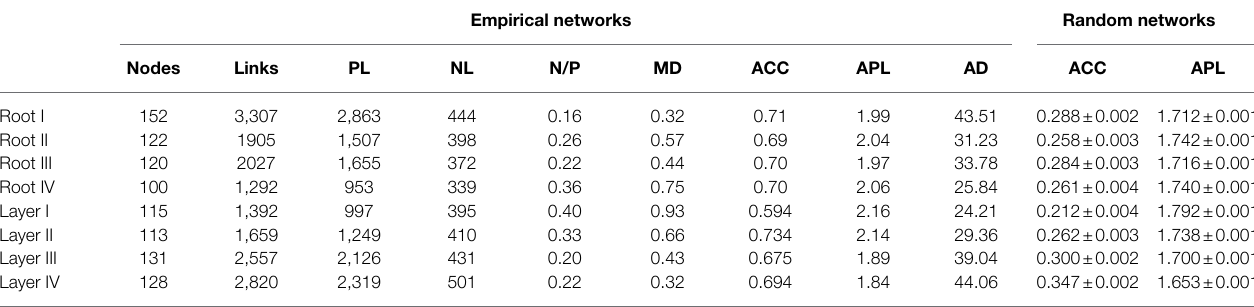
TABLE 1 | Topological features the bacterial networks of different root diameters and rooting